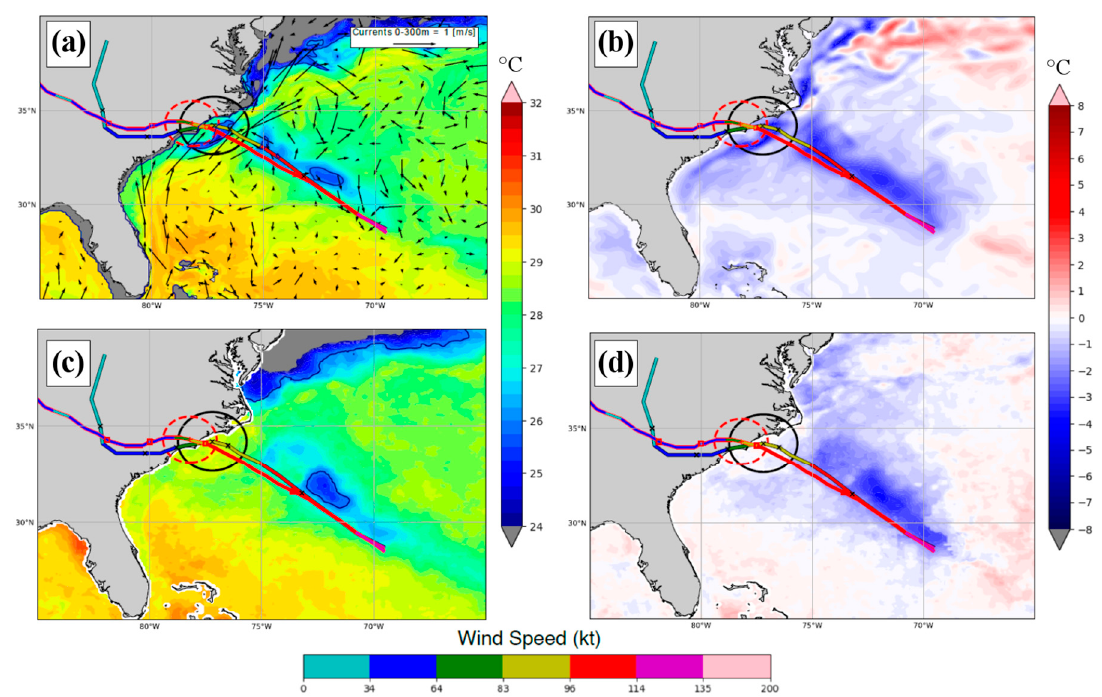
Figure 8. As in Figure 7, except for the case study of Florence (AL062018), model initialization time of 0600 UTC 12 September 2018. Fields shown are for a forecast lead time of 48 h (0600 UTC 14 September 2018): SST ( a , c ) and SST change ( b , d ) for ( a , b ) MPIPOM-TC model output and ( c , d ) MWIR satellite SST.